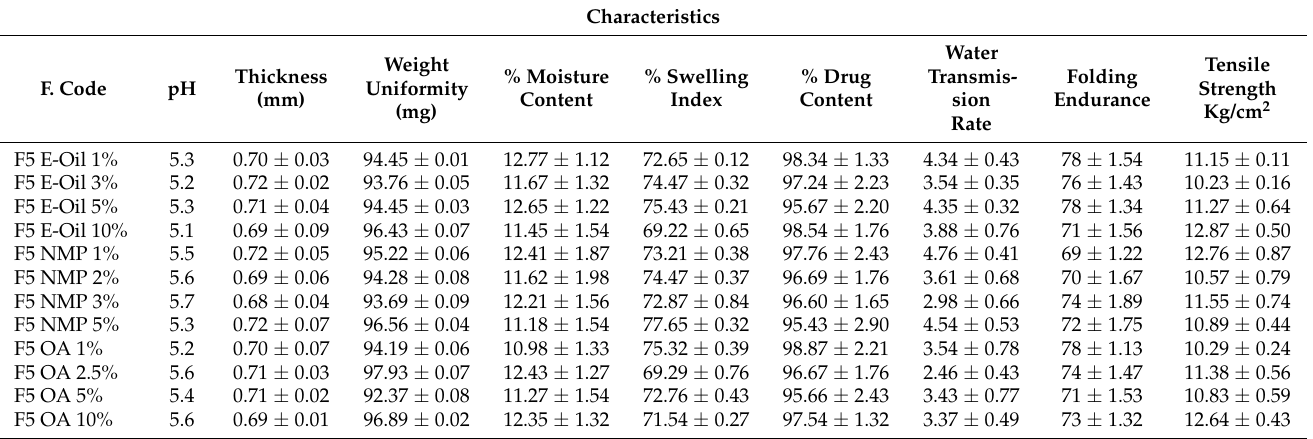
Table 6. Characterization of methotrexate patches with penetration